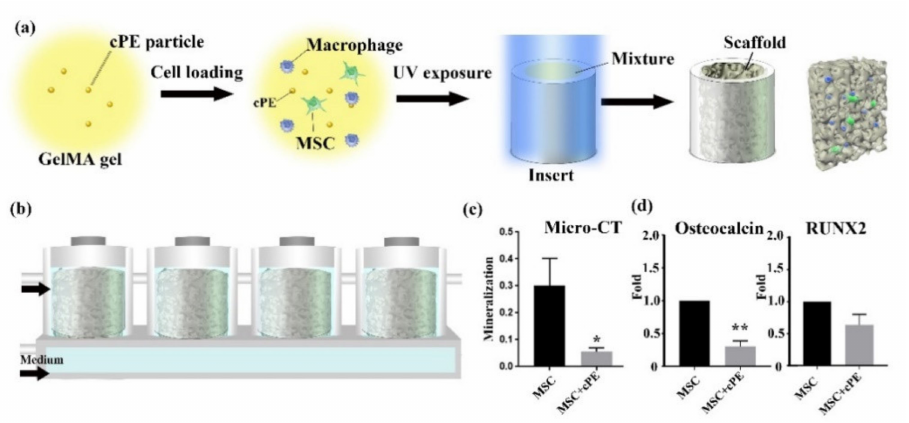
Figure 1. MSCs in 3D culture. cPE decreased bone formation by MSCs. ( a ) Schematic of the bioreactor- based 3D culture system. Cross-section schematic demonstrates cells are embedded in scaffolds. ( b ) Illustration of the custom-designed 3D bioreactor. The medium flows from both top and bottom inlets. Cells are encapsulated in the GelMA scaffold and cultured in the bioreactor. In one bioreactor, 4 scaffolds are connected in series. ( c ) Micro-CT analysis showed a reduction of mineralization in the MSC+cPE group compared to the control MSC group. ( d ) qPCR revealed reduced gene expression of OCN and RUNX2 upon exposure to cPE. (* p < 0.05, ** p <